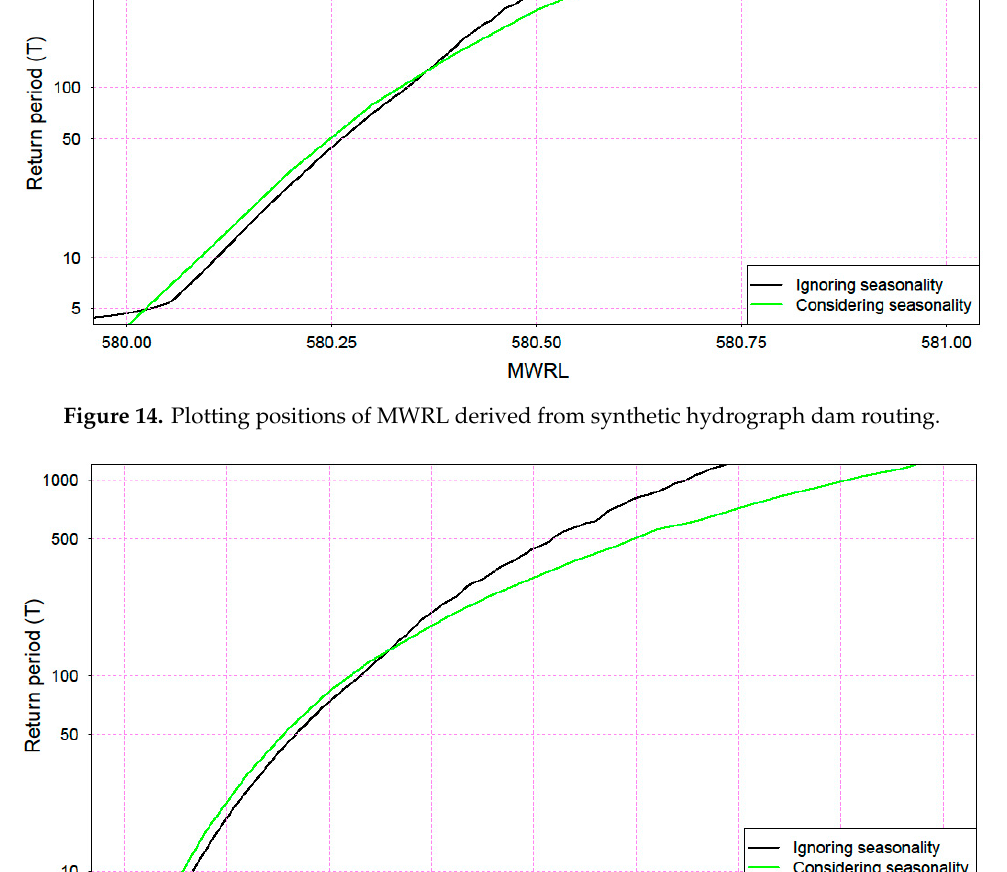
Figure 15. Plotting positions of maxim floods derived from synthetic hydrographs.